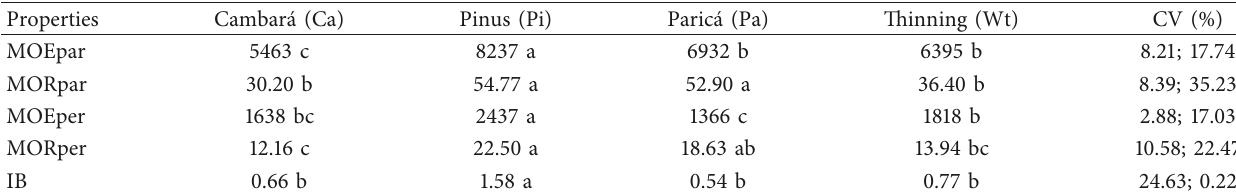
Table 4: Mechanical property results in